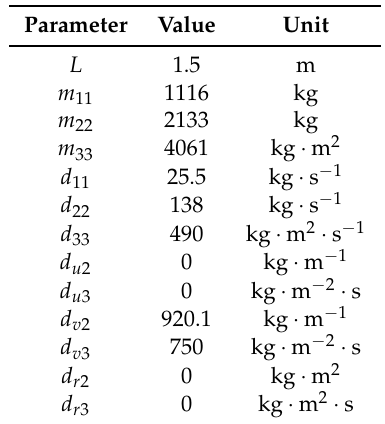
Table 1. The hydrodynamic parameters of the under-actuated AUV moving in the horizontal plane are obtained from Chapter 12 in [57].